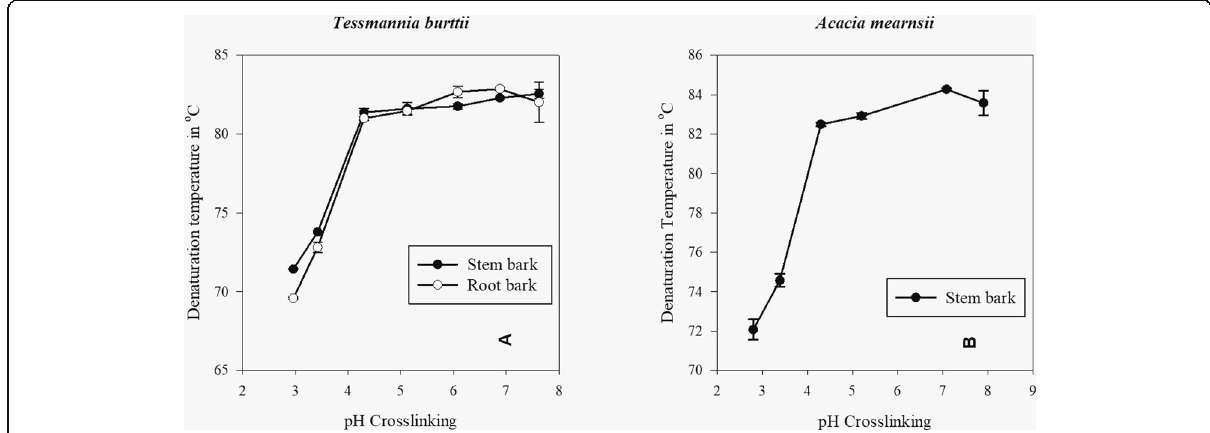
Fig. 2 Denaturation Temperature T onset of hide powder cross-linked with extract of Tessmannia burttii ( a ) and Acacia mearnsii ( b ) extracted at 50 °C with pH